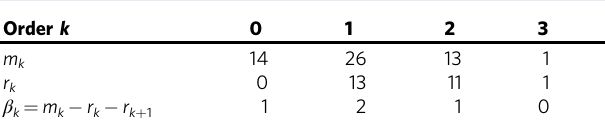
Table 2 Computational results of the network are shown in Fig. 1. Order